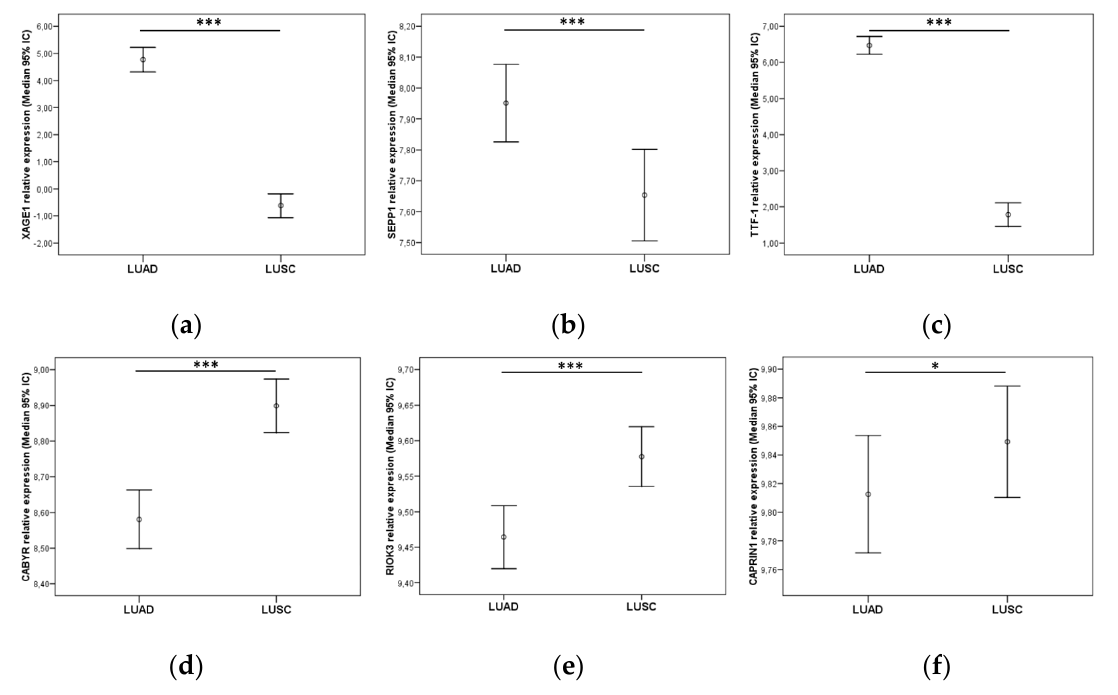
Figure 7. Relative expression of ( a ) XAGE1 , ( b ) SEPP1 , ( c ) TTF-1 in the TCGA LUAD cohort and ( d ) CABYR , ( e ) RIOK3 , ( f ) CAPRIN1 in the LUSC cohort. Graphics represent median with 95% CI (confidence interval). p -values were obtained using Mann–Whitney U-tests. Significance values were * p < 0.05 and *** p ≤ 0.001. Table 3. Clinicopathological characteristics of the patients included in the HGUV NSCLC cohort.